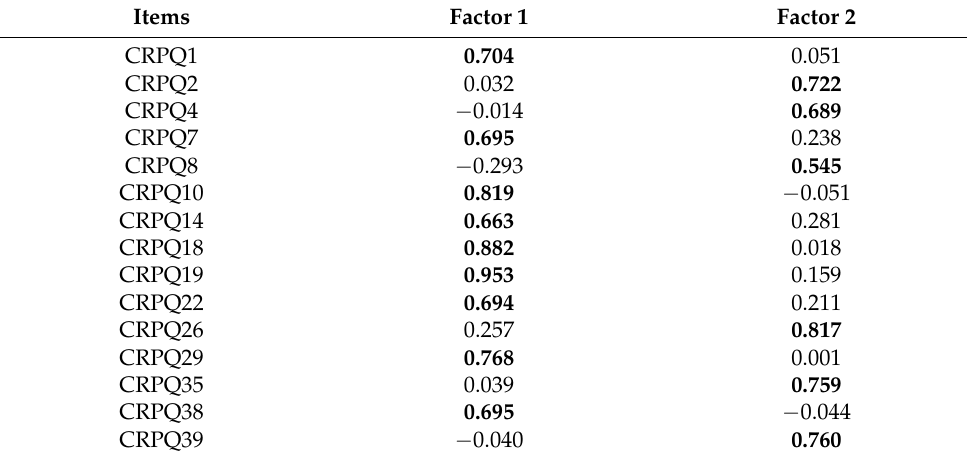
Table 3. Promax rotation for items of the CRPQ (Sample